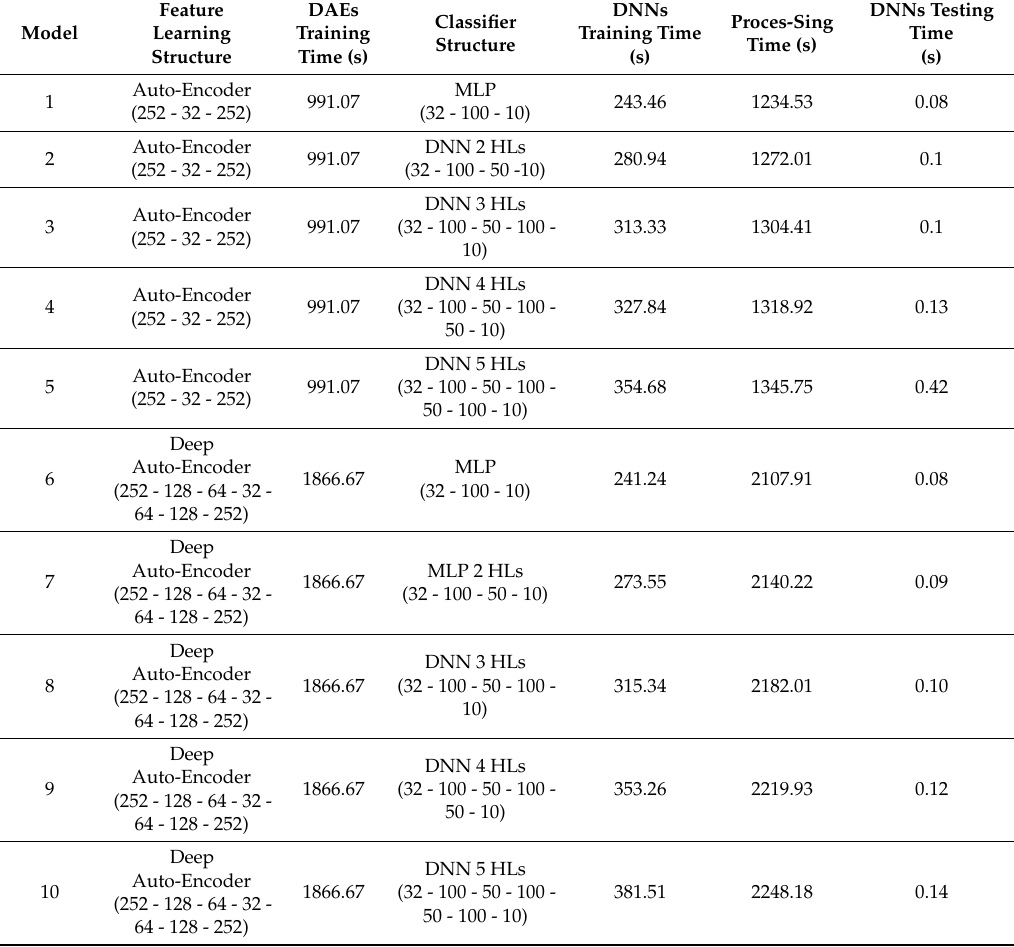
Table 2. Processing time of 10 DL structures.